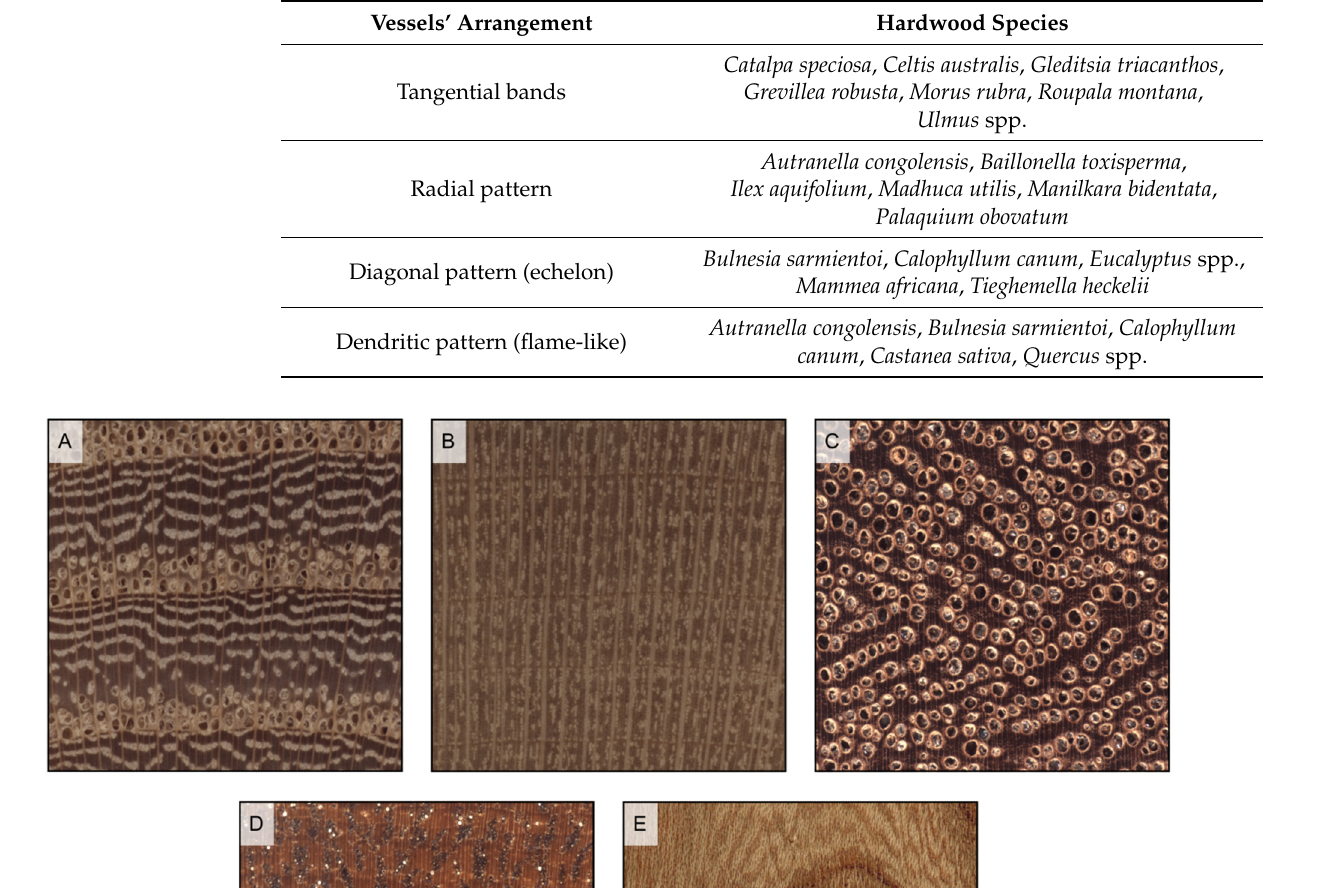
Table 12. Examples of species for different types of vessels’ arrangement.